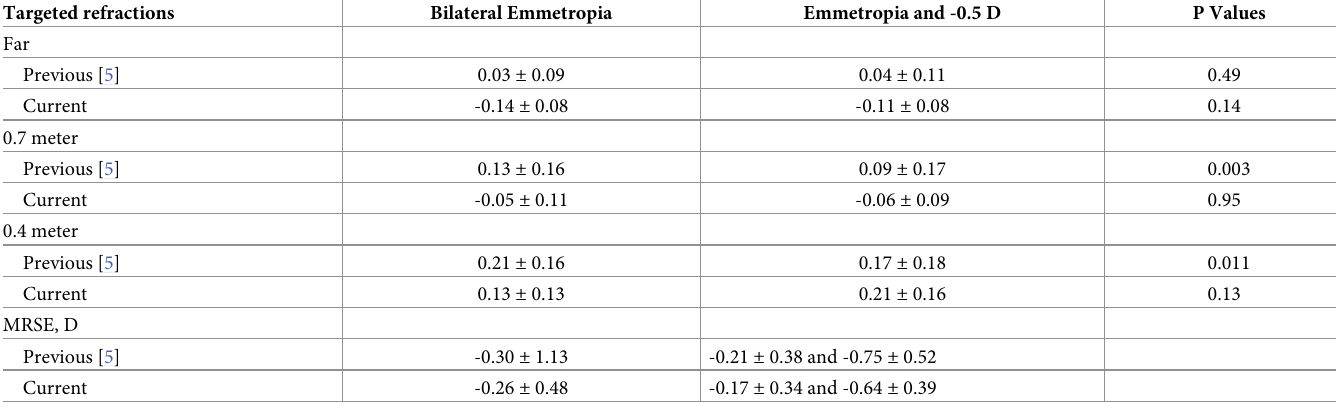
Table 4. Comparison of binocular uncorrected visual acuities in a previous study [5] with the current results. Targeted refractions Bilateral Emmetropia Emmetropia and -0.5